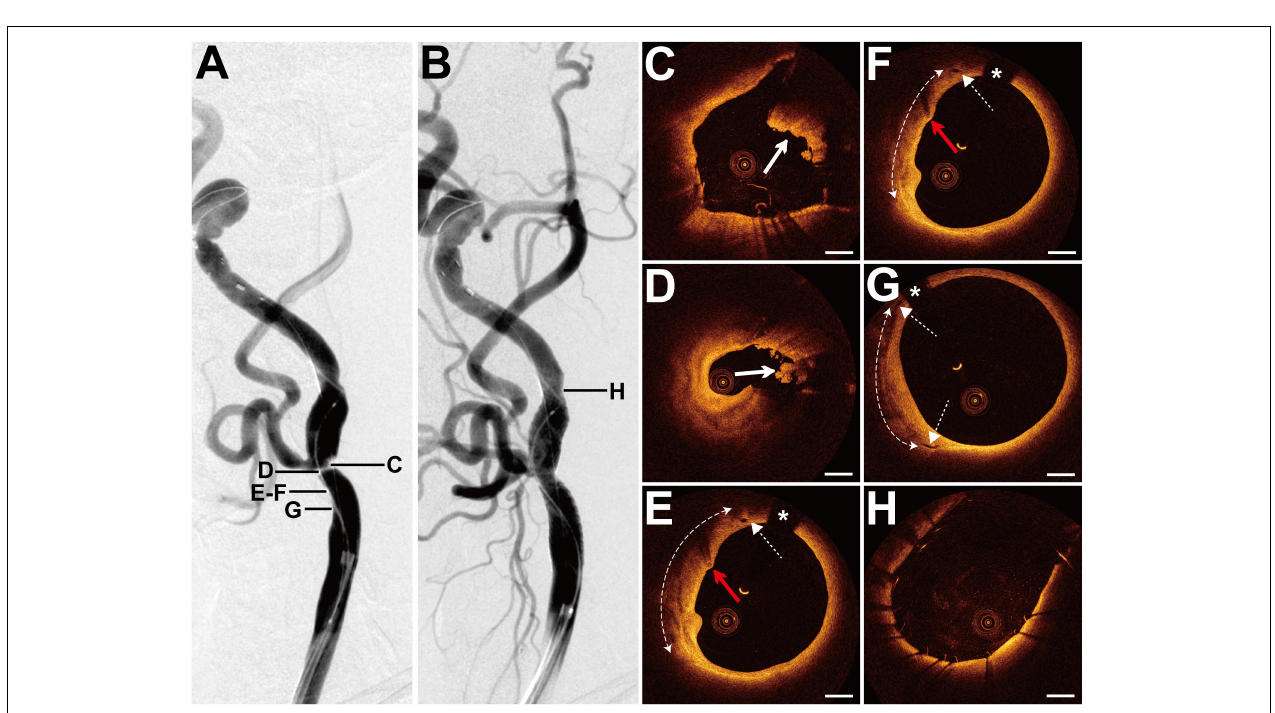
FIGURE 5 | DSA and OCT findings of the LCCA lesion. Case 5. (A) The angiogram before stenting showed severe stenosis at the bifurcation of the LCCA. (B) The angiogram after stenting. (C) The intraluminal thrombus (arrow). (D) The fibrous plaque with the intraluminal thrombus (arrow) at the minimum lumen. (E–G) Images (E,F) are adjacent OCT images. The lipid-rich plaque (dashed curve with arrows) with macrophage accumulations (red arrows) and adjacent microvessels (dashed arrows) were detected. (H) Post-interventional OCT image. Most stent struts were well apposed, and some of the vessel walls were out of the imaging range. Scale bars represent 1 mm. Asterisks denote guide-wire artifact. DSA, digital subtraction angiography; LCCA, left common carotid artery; OCT, optical coherence tomography.